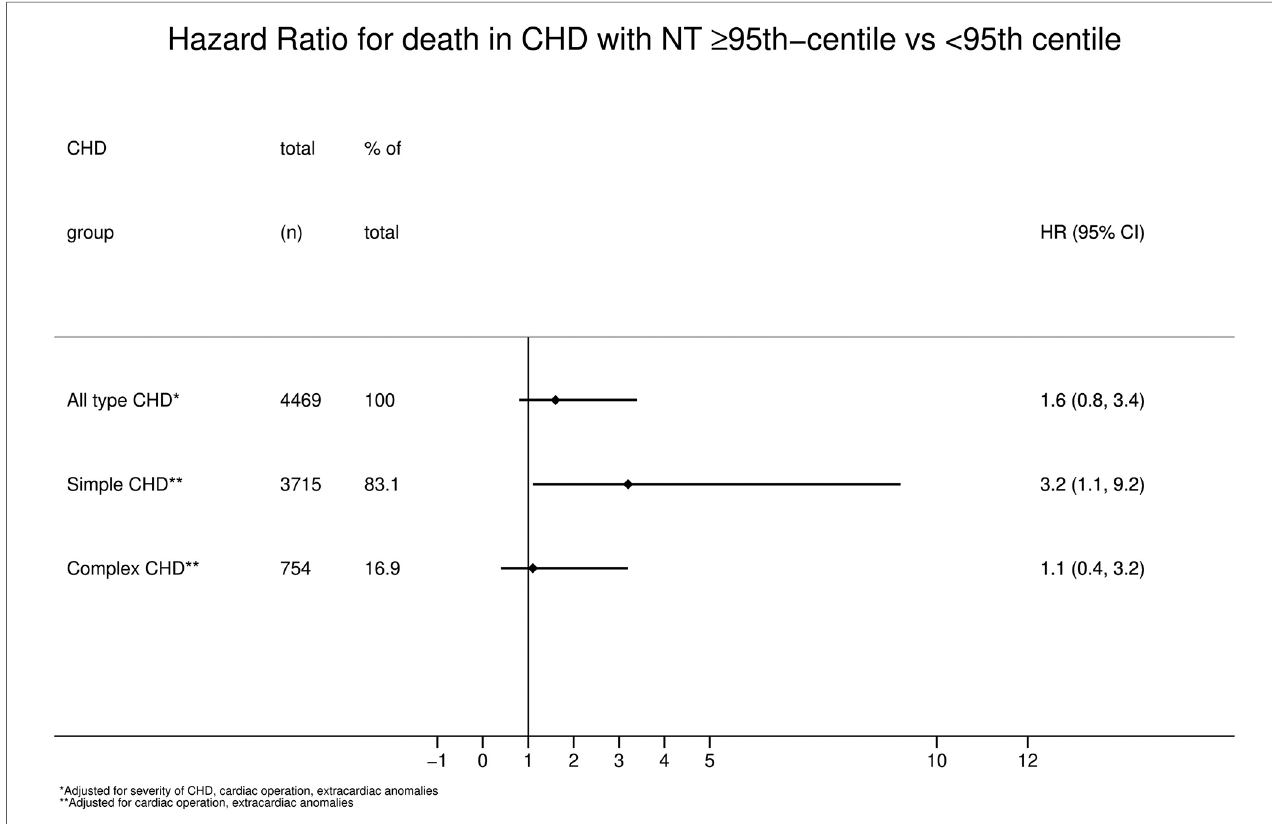
FIGURE 3 Hazard ratio for mortality in CHD with NT ≥ 95th centile vs. < 95th Centile. CHD, congenital heart defect; NT, nuchal